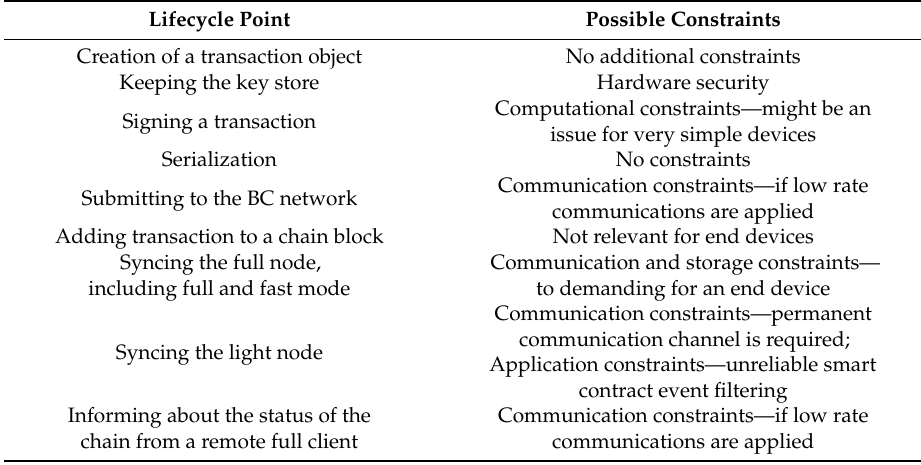
Table 2. Possible constraints in an Ethereum transaction